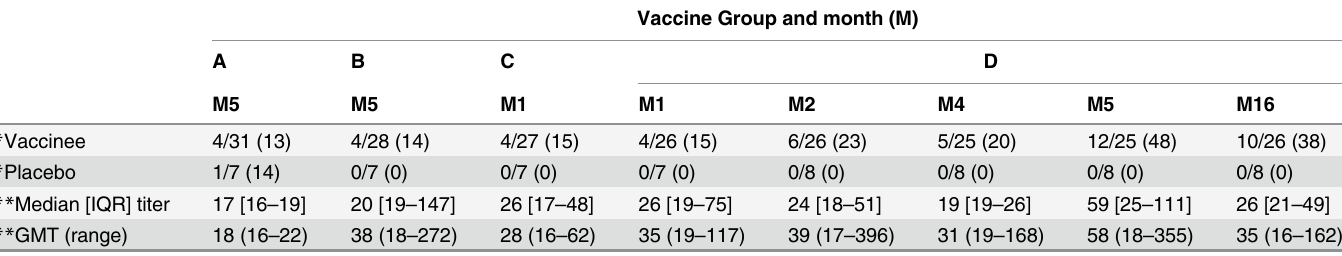
Table 3. Ad35 Neutralization response rates and titers